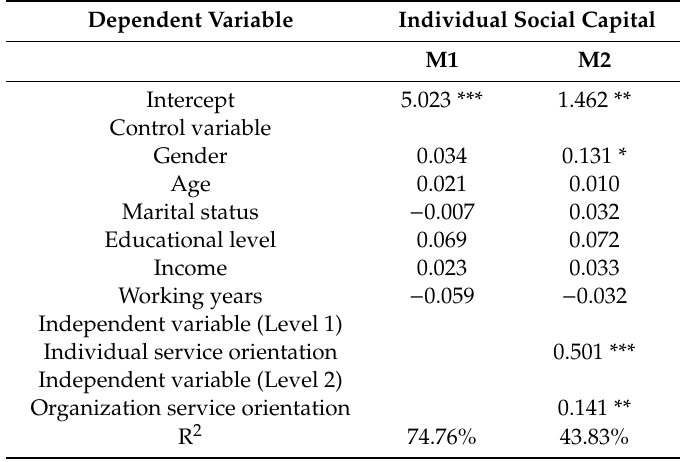
Table 6. Multilevel antecedent’s examining results of individual social capital.